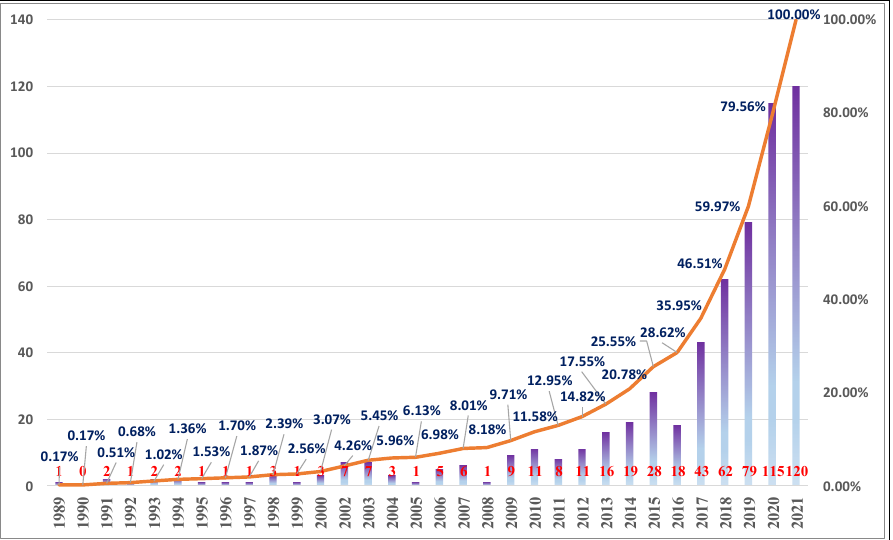
Figure 9. Number of articles published in the top 15 journals.